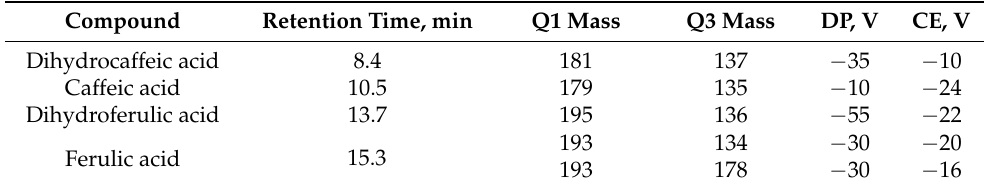
Table 1. LC-MS/MS characteristics of phenolic compounds in the negative